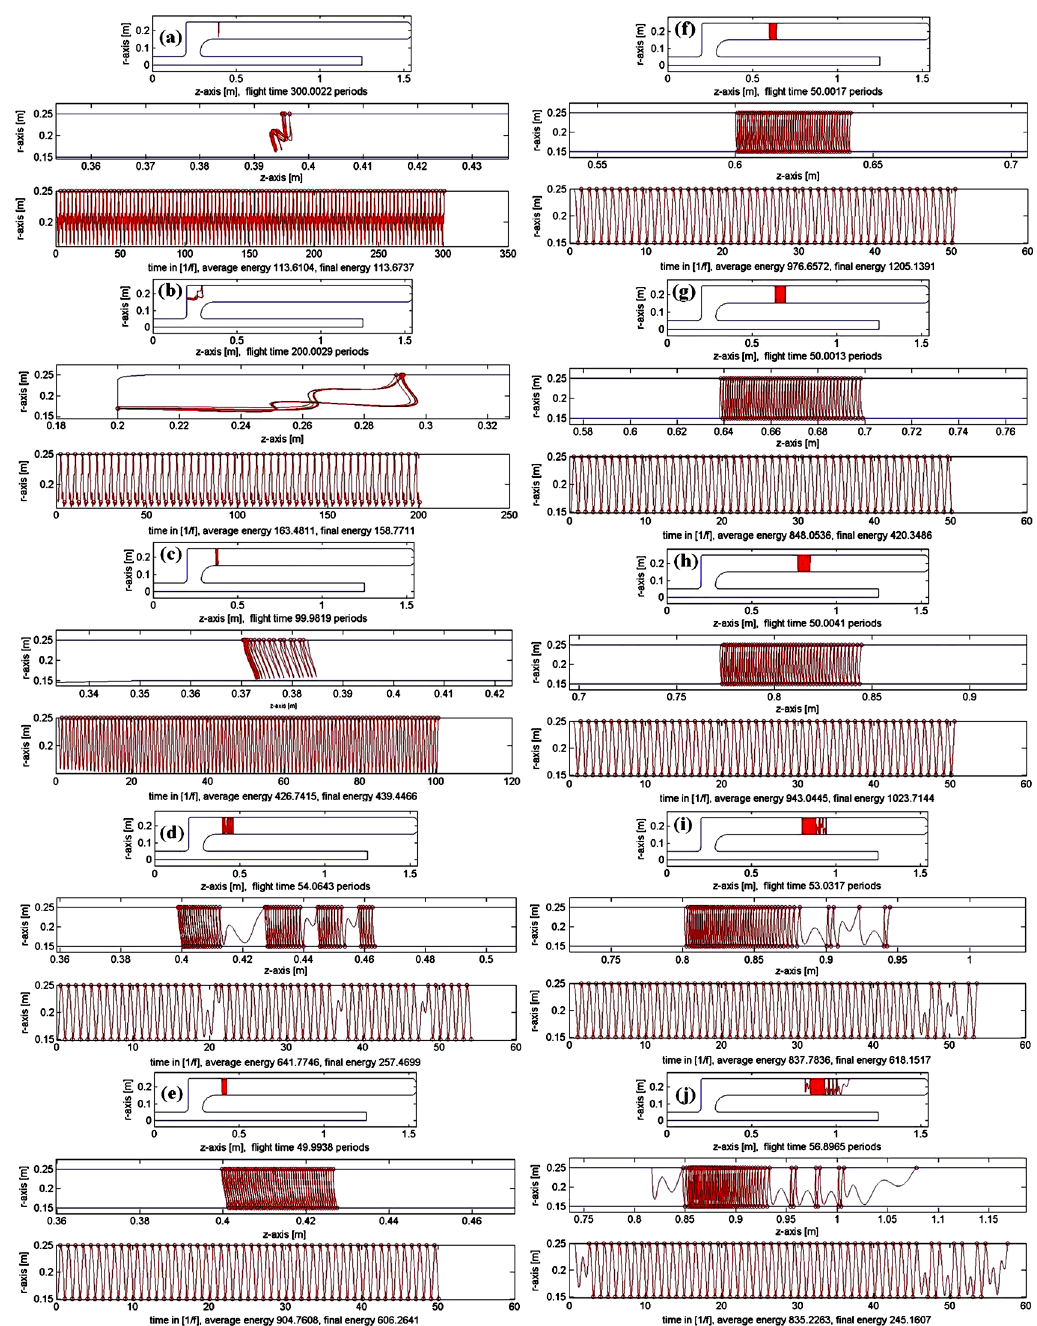
FIG. 7. (Color) (a) The electron’s trajectory in third-order single-point multipacting at 25 kV = m . The top figure represents the trajectory of the electron in ð r; z Þ coordinates, the middle one is an expanded plot of a part of the top one, and the bottom plot illustrates the electron’s trajectory in the ð r; t Þ coordinates where t is the time in rf periods. The circles indicate the impacts on the walls of the cavity. (b) Electron trajectory in two-point multipacting at 31 kV = m . It is a combination of first and second-order two-point multipacting. (c) The electron’s trajectory in first-order single-point multipacting at 47 kV = m . (d) The first-order two-point multi- pacting electron trajectory at 35 kV = m showing its tendency to move towards the end of the cavity. (e) The first-order two-point multipacting at peak surface electric fields 36 kV = m . (f) The first-order two-point multipacting at peak surface electric fields 40 kV = m . (g) The first-order two-point multipacting at peak surface electric fields 40 kV = m . The stable electron stable trajectories are found right to the multipacting location shown in Fig. 7(f). (h) The first-order two-point multipacting at peak surface electric fields 46 kV = m . (i) The first-order two-point multipacting at peak surface electric fields 46 kV = m . The stable electron stable trajectories are found right to the multipacting location shown in Fig. 7(g). (j) The first-order two-point multipacting at peak surface electric fields 50 kV = m